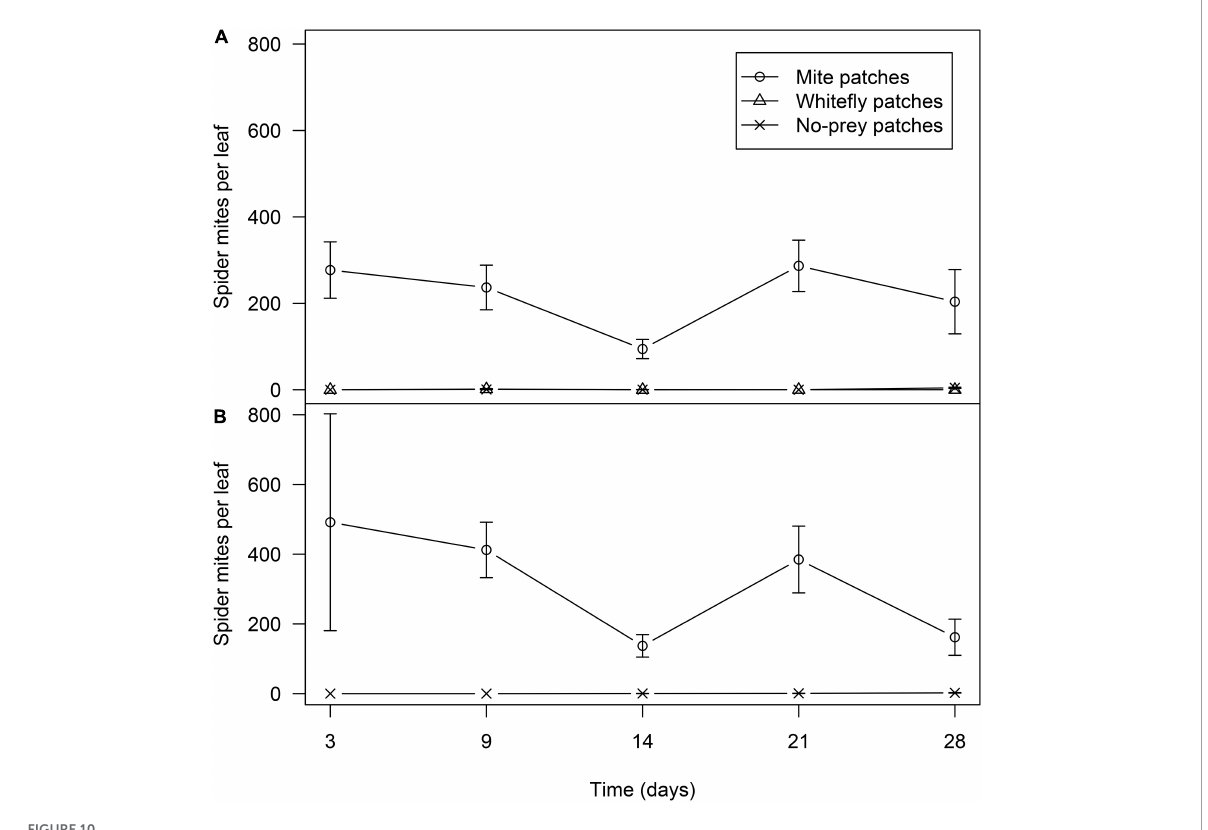
FIGURE10 Average of spider mites and standard error in no-prey, mite and whitefly patches in mixed-prey (A) and whitefly habitats (B)